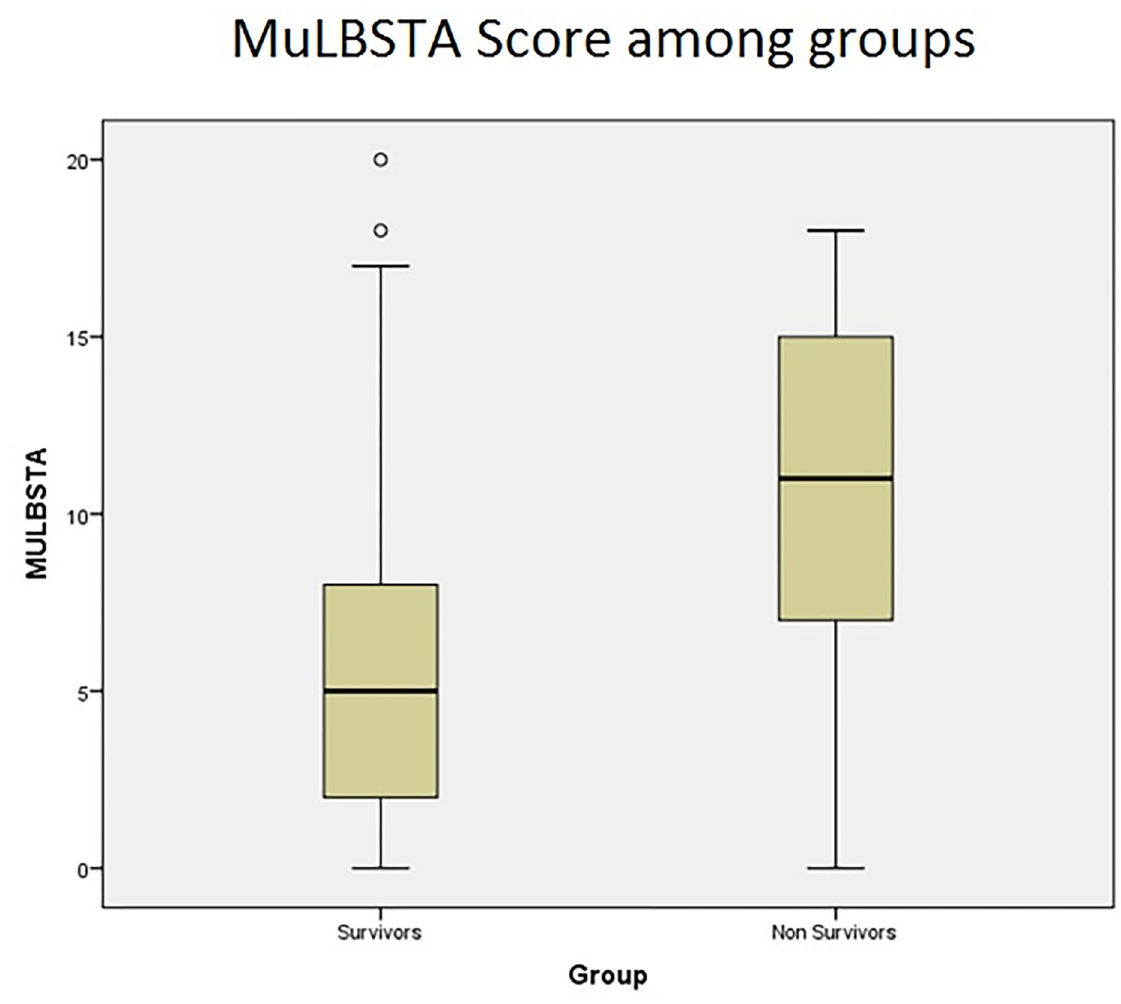
Fig 3. MuLBSTA score among